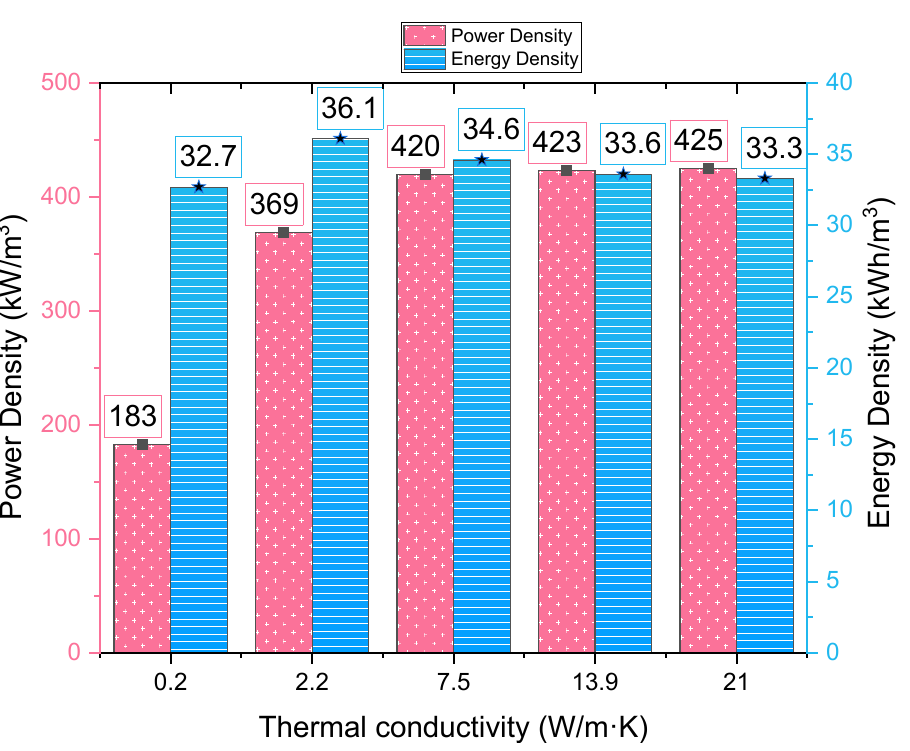
Figure 12. Energy and power density with the PCMs of different thermal conductivities.